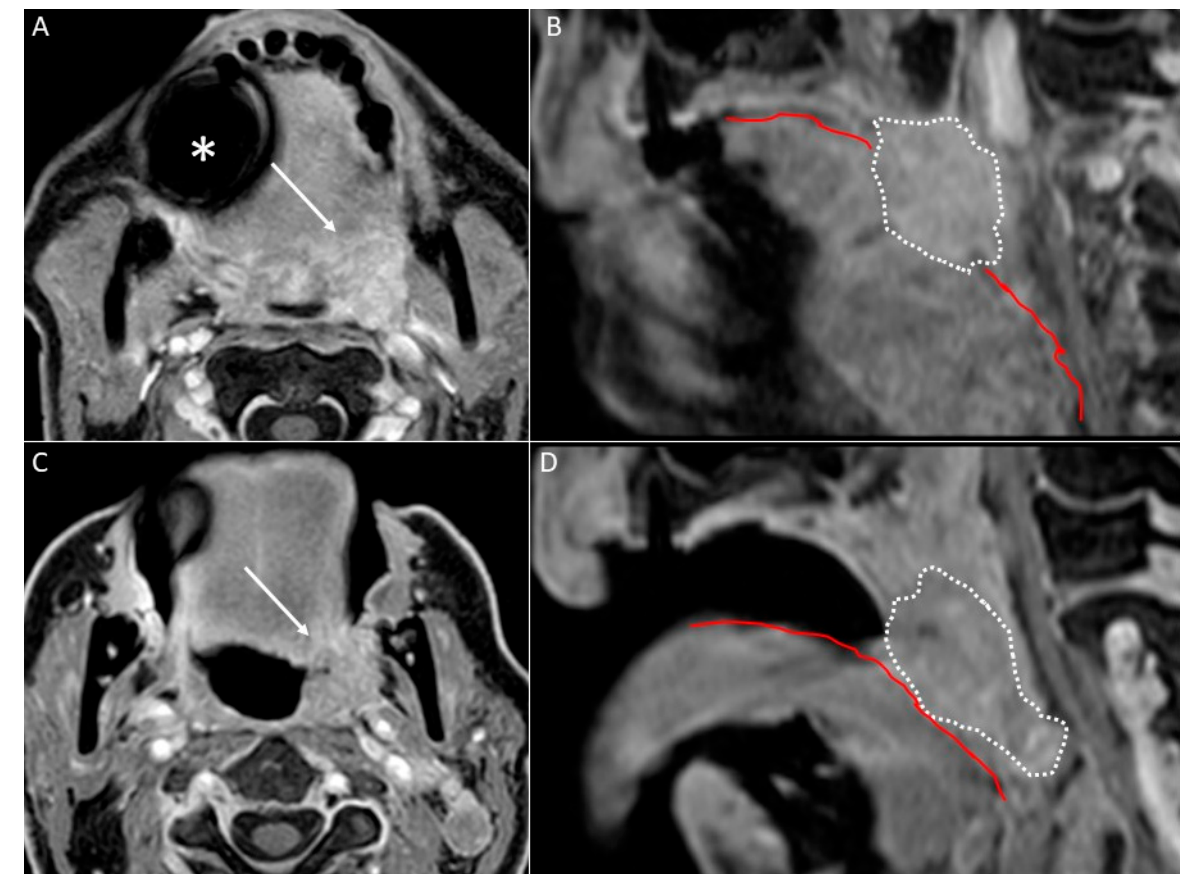
Figure 16. Open Mouth with Tongue extended MRI technique. ( A ) T1 contrast-enhanced axial image and ( B ) T1 contrast-enhanced sagittal image showing a left tonsillar neoplasm (arrow in ( A ), outlined by white dotted line in ( B )) where it is not possible to distinguish between the infiltration of the tongue (outlined by the red line in ( B )) and the surrounding muscles. ( C ) T1 contrast-enhanced axial open mouth with tongue extended and ( D ) T1 contrast-enhanced sagittal open mouth with tongue extended of the same patient where it is possible to appreciate how the neoplasm (arrow in ( C ), outlined by white dotted line in ( D )) is well separated from the lingual surface (outlined by the red line in ( D )) and neighbouring structures. The lingual protrusion causes “stretching” of the oropharyngeal structures and distends the glosso-tonsillar sulcus. Therefore, the tonsillar compartment is isolated. In case of tonsillar neoplasia, it is possible to confirm or deny the invasion of the tongue base, styloglossus, pterygoid muscles, and the lateral wall of the pharynx—and vice versa for a lingual neoplasm. In ( A ) a susceptibility artifact, given by the interface between the ferromagnetic material and the adjacent tissues causing magnetic distortions and signal loss, is clearly visible (*).